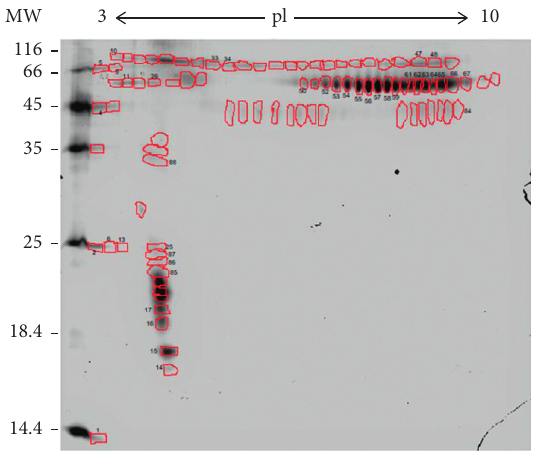
Figure 1: Two-dimensional polyacrylamide gel